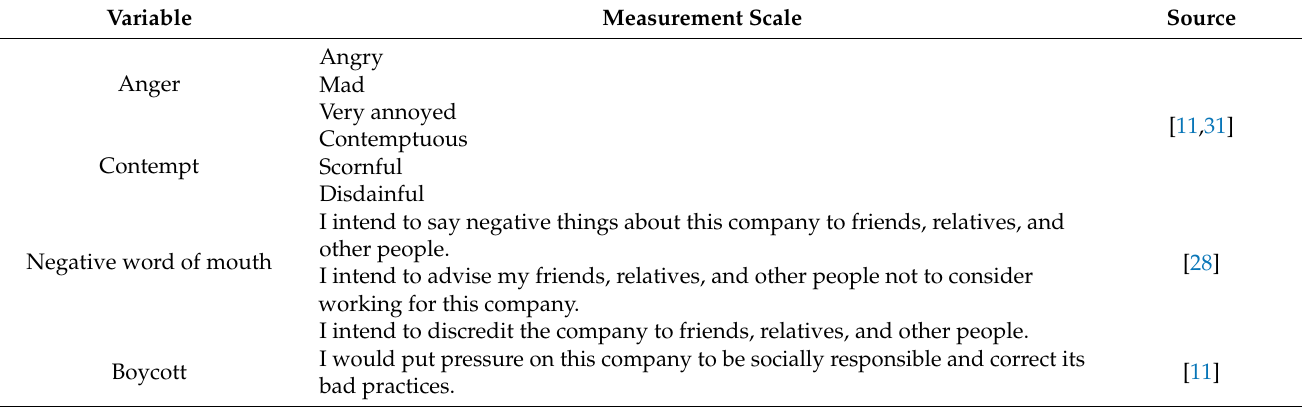
Table 1. Variable measurement scale.